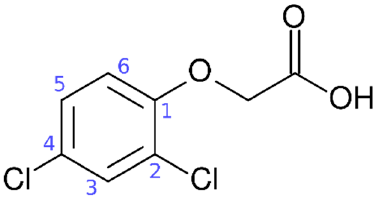
Figure 1. Chemical structure and functionality of the 2,4-dichlorophenoxy acetic acid (2,4-D).